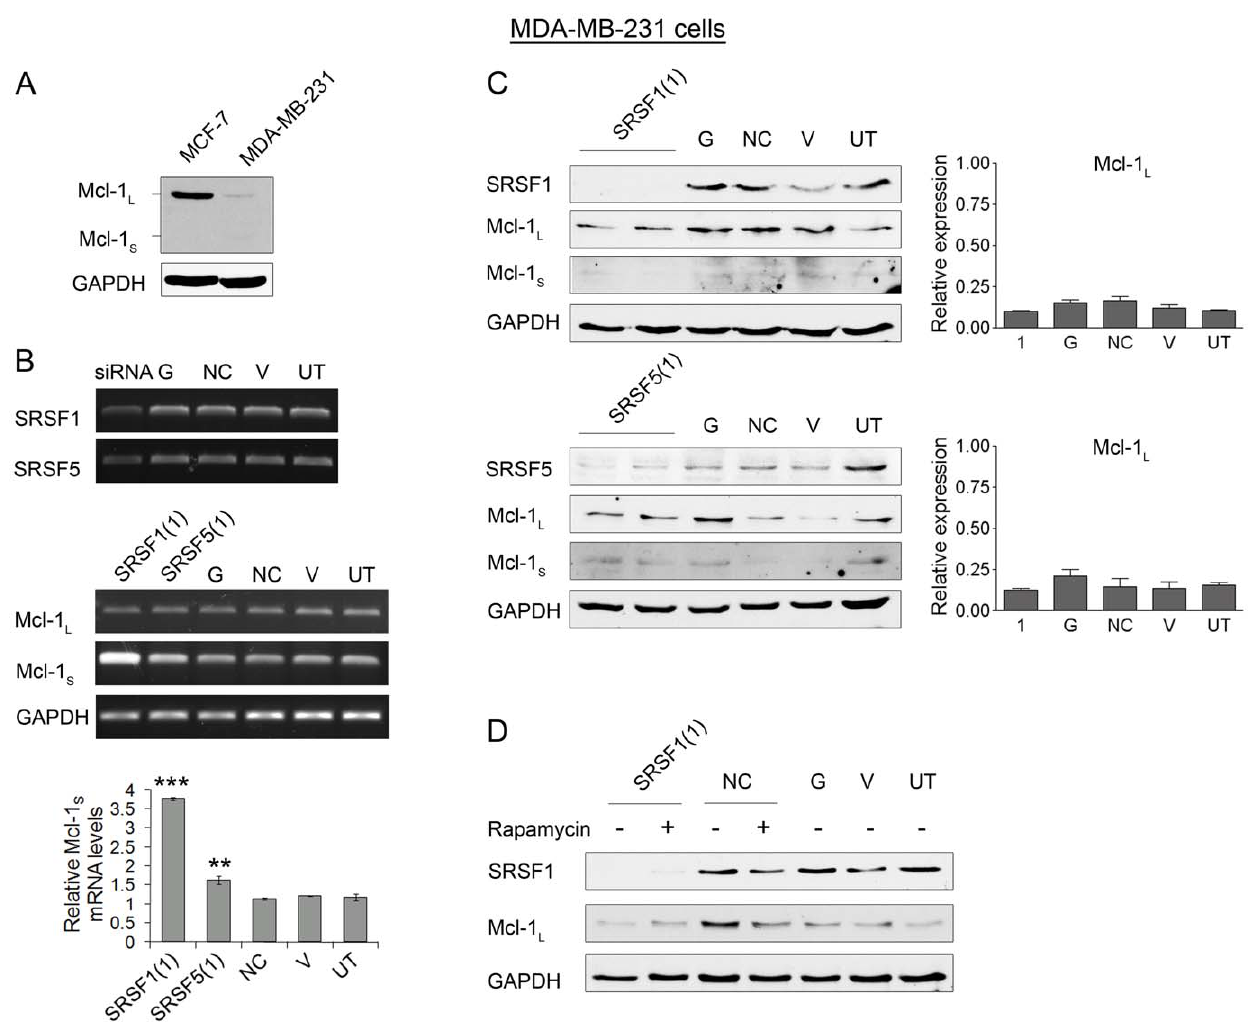
Figure 7. Effect of SRSF1 and SRSF5 knockdown on expression, stability and translation of Mcl-1 L in MDA-MB-231 cells. ( A ) Detection of Mcl-1 splice variants and GADPH proteins in MCF-7 and MDA-MB-231 using 40 ug of total cell lysate from both cell types. Histograms show densitometric analysis of Mcl-1 L and Mcl-1 S protein expression. Data are shown as the mean 6 SEM. ( B ) Semi-quantitative RT-PCR showing knockdown of RNA binding proteins 48 hours after transfection with siRNAs. MDA-MB-231 cells were transfected with SRSF1, GAPDH (G) and Negative control (NC) siRNAs, or treated with vehicle (lipid) only (V), or were left untreated (UT). Semi-quantitative RT-PCR showing levels of the Mcl-1 splice isoforms (Mcl-1 L and Mcl-1 S ) and the loading control GAPDH 72 hours after transfection with siRNAs. Mcl-1 S levels in sample replicates measured by real-time PCR (mean (n=3) 6 SEM). ( C ) MDA-MB-231 cells were transfected with SRSF1, SRSF5, GAPDH (G) and Negative control (NC) siRNAs, or treated with vehicle (lipid) only (V), or were untreated (UT). SRSF1, 5, Mcl-1 and GAPDH protein levels were determined by immunoblotting 72 hours after transfection with the siRNAs, using 30 m g of total cell lysate. ( D ) MDA-MB-231 cells were transfected with SRSF1, GAPDH (G) and negative control (NC) siRNA, or treated with vehicle (lipid) only (V), or were untreated (UT). 48 hours after transfection cells were treated with 20 nM rapamycin for a further 24 hours. Immunoblotting was then used to assess protein levels of SRSF1, Mcl-1 L and GAPDH (mean (n=3) 6 SEM). *** indicates P # 0.001; ** P # 0.01.